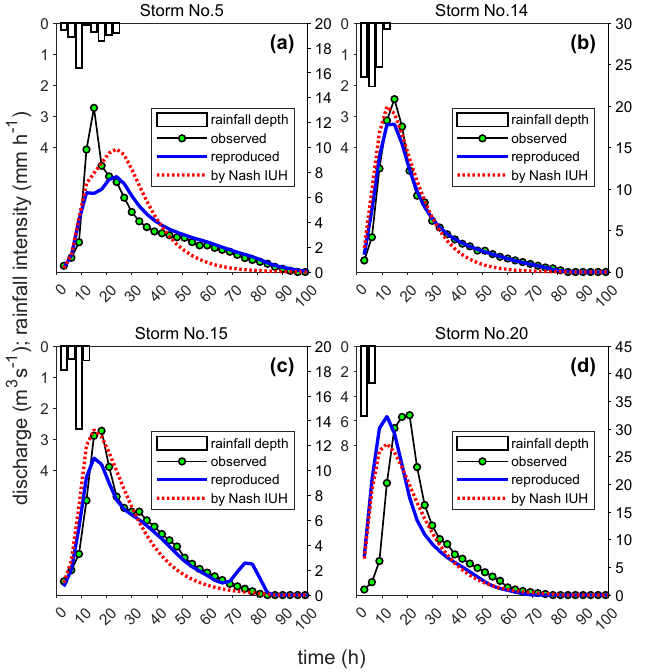
Figure 4. Comparison of reproduced runoff with that observed for each storm: ( a ) for Storm No. 5; ( b ) for Storm No. 14; ( c ) for Storm No, 15; ( d ) for Storm No. 20.